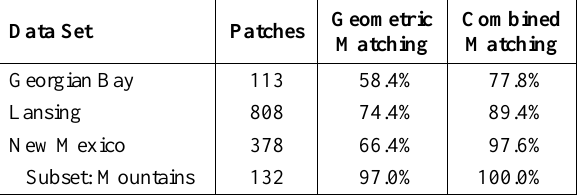
Table 4. Percentages of reliable strip offsets, based on the total number of evenly distributed patches.